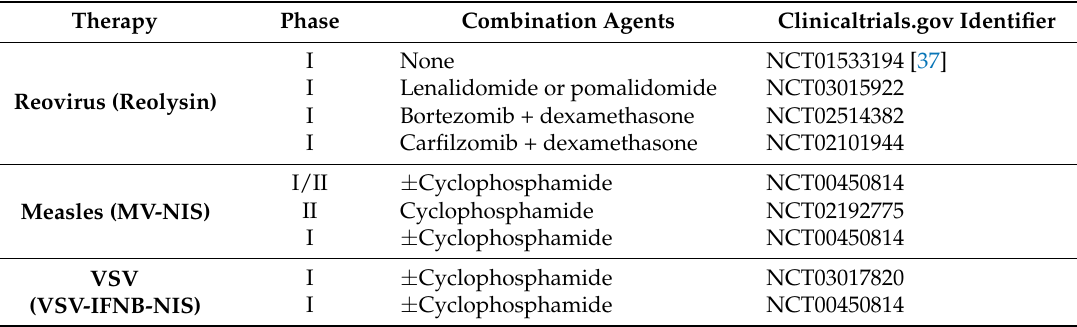
Table 2. Clinical trials for oncolytic viruses in multiple